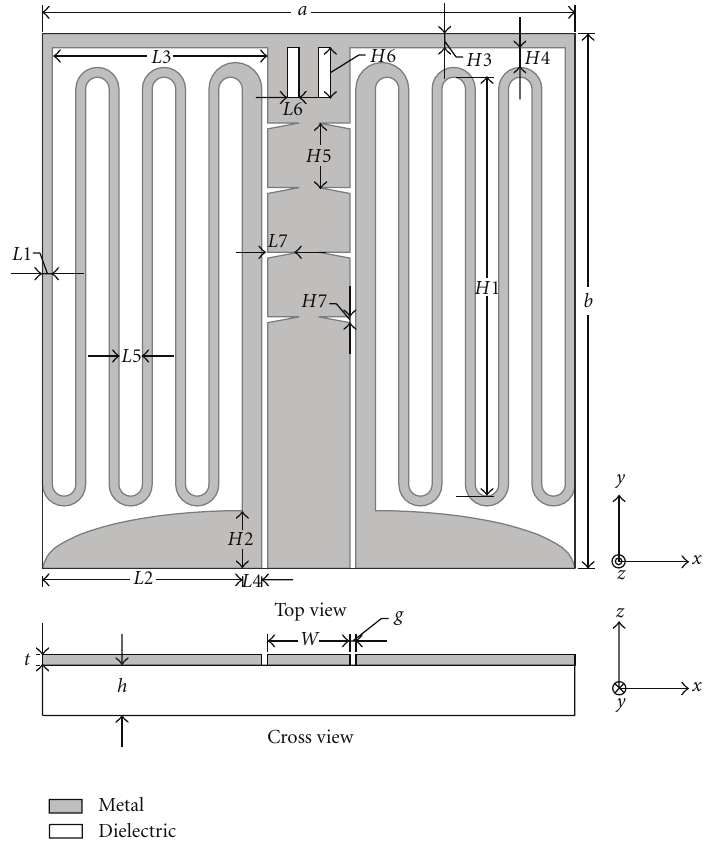
Figure 1: Geometry configuration of proposed antenna.